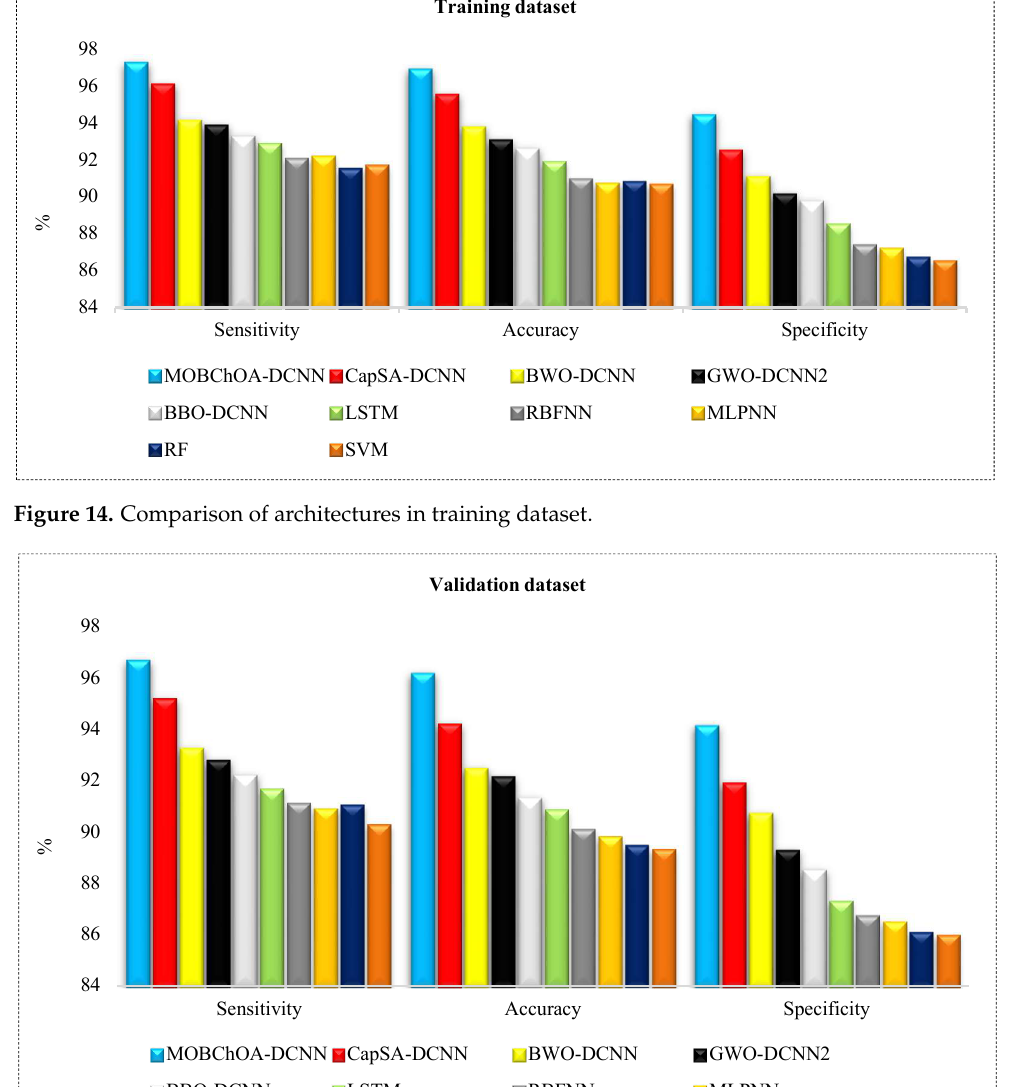
Figure 14. Comparison of architectures in training dataset.